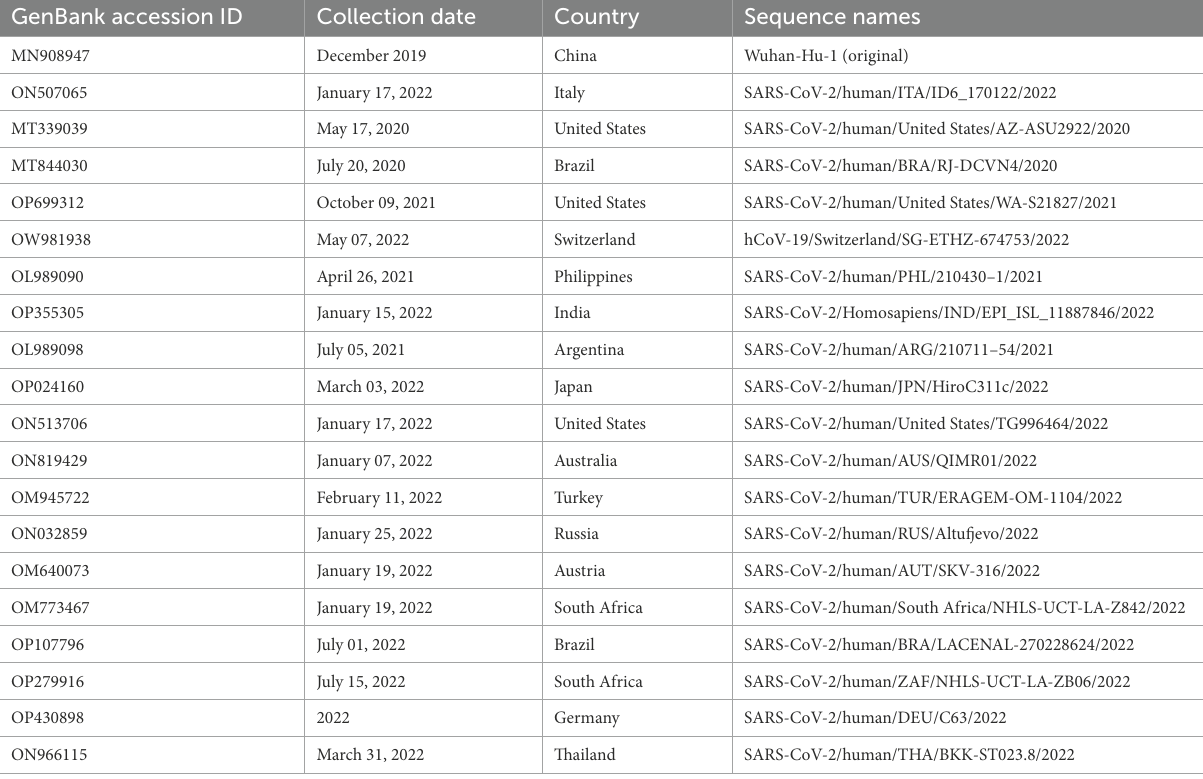
TABLE 1 List of the initially recruited 20 SARS-CoV-2